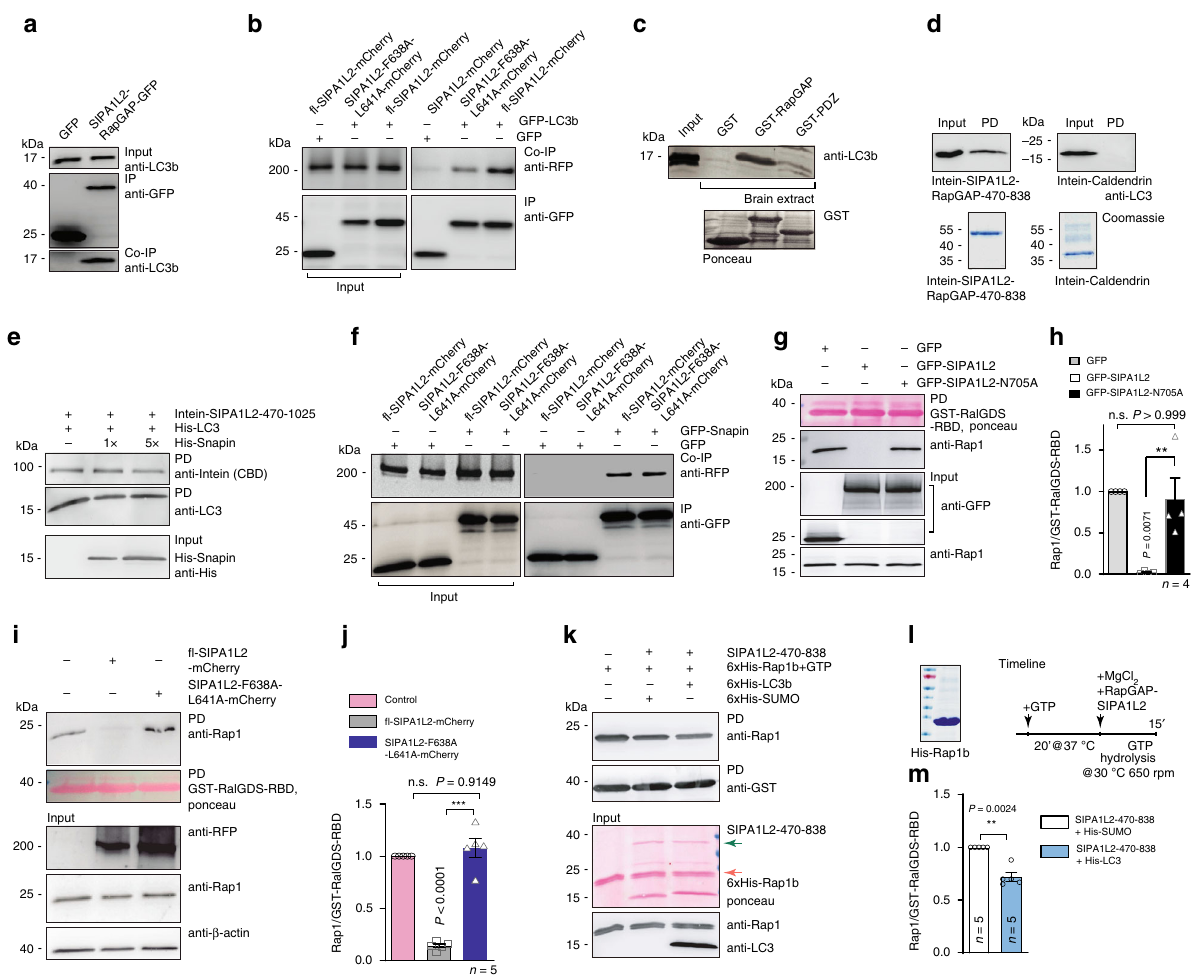
Fig. 4 LC3 interacts with the RapGAP domain of SIPA1L2 and promotes RapGAP activity. a RapGAP-GFP but not GFP immunoprecipitates endogenous LC3 from a HEK293T cell extract. b Heterologous Co-IP from HEK293T cells showing a reduced interaction between GFP-LC3b and SIPA1L2-F638A-L641A- mCherry, which harbors a mutation within the LIR motif (FxxL/AxxA), when compared to fl -SIPA1l2-mCherry. c GST-RapGAP but not GST-PDZ domain of SIPA1L2 pulled down endogenous LC3 from rat brain extracts. The Ponceau staining indicates protein loading. d Intein-RapGAP domain of SIPA1L2 (SIPA1L2-470-838) pulls down bacterially expressed His-LC3b. Intein-Caldendrin was used as a nonrelated control. Coomassie blue staining is shown below. e Pull-down assay performed in the presence of Snapin. Note that an excess (5×) of Snapin does not interfere with the binding of LC3b to the RapGAP domain (SIPA1L2-470-1025). Intein tag is detected using anti-CBD antibodies against the Chitin Binding Domain of Intein and is depicted as anti- Intein (CBD). f Both fl -SIPA1L2-mCherry and SIPA1L2-F638A-L641A-mCherry coimmunoprecipitates GFP-Snapin from HEK293T cell extracts. g , h RapGAP activity assay shows decreased pull-down of Rap1-GTP from HEK293T cell extracts in the presence of GFP-SIPA1L2 but not GFP-SIPA1L2-N705A. The bar graph in h shows the quanti fi cation of the Rap1/RalGDS-RBD ratio from four independent experiments (one-way ANOVA with Bonferroni ’ s correction). i , j SIPA1L2-mCherry but not SIPA1L2-F638A-L641A-mCherry reduces Rap1-GTP pull-down with GST-RalGDS-RBD when expressed in HEK293T cells. Quanti fi cation of the Rap1/GST-RalGDS-RBD ratio is shown in j (one-way ANOVA with Bonferroni ’ s correction). k – m Rap-GAP activity assay performed with recombinant SIPA1L2-470-838 in the presence of His-LC3b or His-SUMO as a negative control. In l , time line of the RapGAP activity assay and purity of His-Rap1b con fi rmed by SDS-PAGE and Coomassie blue staining. In m , quanti fi cation of the Rap1-GST-RalGDS-RBD ratio shows the effect of LC3b on enhancing RapGAP activity of SIPA1L2 (paired Student ’ s t test). Bars and error bars represent data as mean ± SEM. N number in the graph corresponds to number of independent experiments. n.s. not signi fi cant. "**" indicates P ≤ 0.01; "***" indicates P ≤